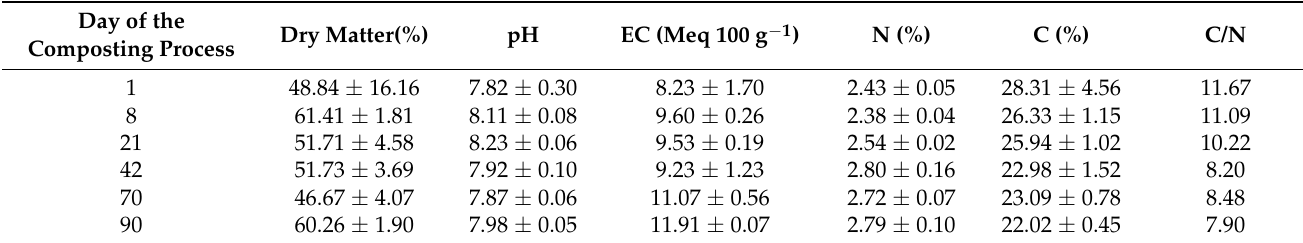
Table 4. Chemical parameters change during composting process (day 1 to 90): dry matter, pH, electrical conductivity (EC) (1/5 mL H 2 O), total nitrogen (N) content, total organic carbon (TOC) and C/N ratio.